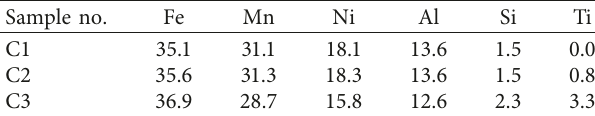
Table 1: Chemical composition of the prepared HEAs in wt.%. Sample